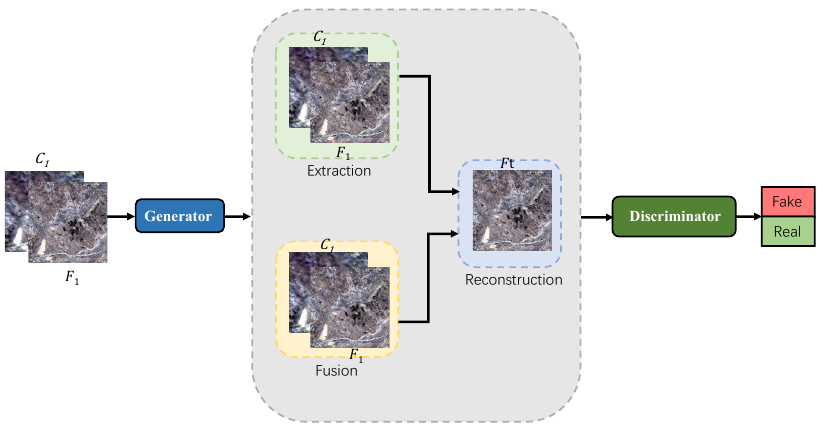
Figure 2. MCBAM-GAN overall architecture diagram in which the generator phase consists of feature extraction, feature fusion and multi-scale reconstruction (see the insensitive model [18] in the generator phase, where F 1 and C 1 represent the synthetic fine resolution image and the observed coarse resolution image at the prediction date and time t 1 and t 0 , respectively). On the input F 1 and C 1 The features are extracted and fused respectively, and finally the high-quality fine image of the predicted time is